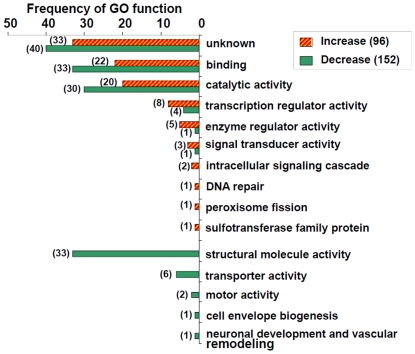
Function classification of desiccation-responsive genes in Anopheles gambiae.Gene annotations were derived from gene ontology. The detailed list of the desiccation-responsive genes is in Table S1.